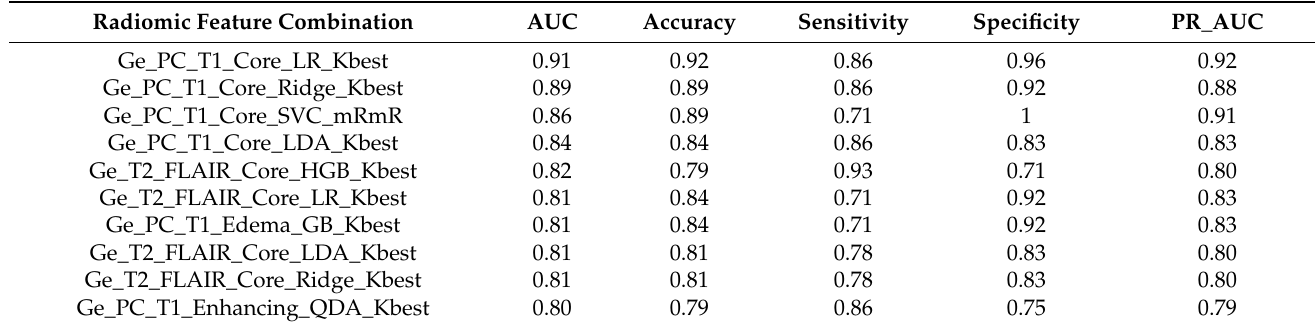
Table 4. Best 10 performances of multi-segmentation approaches, multi-machine learning classifiers, and multi-feature selection algorithms in discriminating IDH-mutant grade 4 astrocytomas from IDH-wild-type GBMs using generated (Ge) data with 30% training